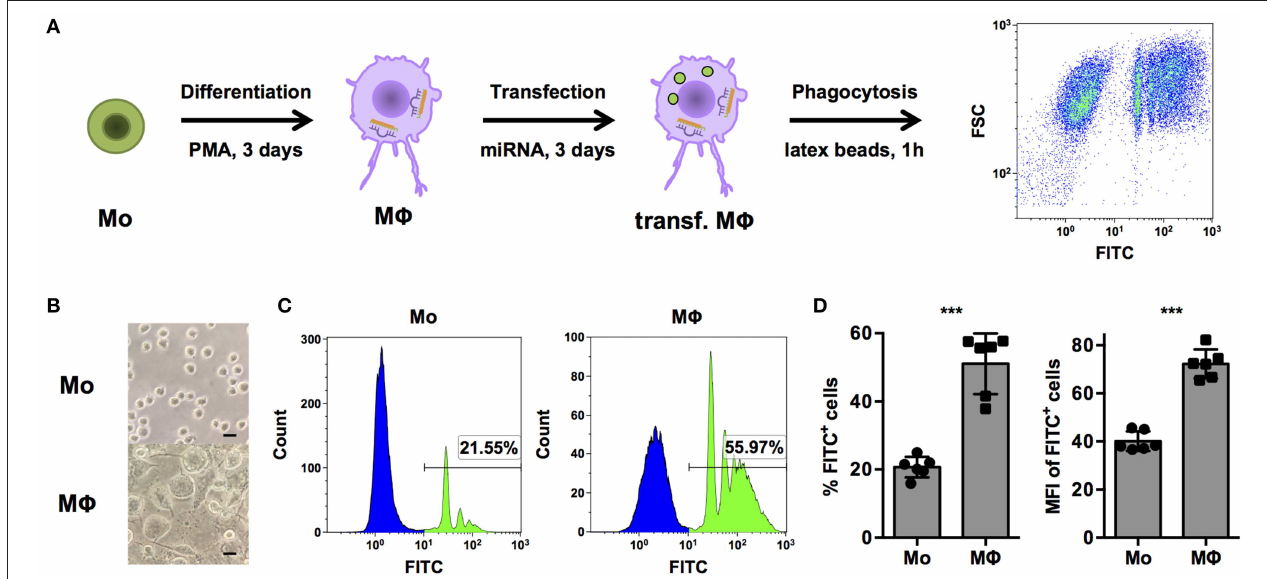
FIGURE 1 | PMA-activated THP-1 cells allow investigation of phagocytosis of opsonized latex beads by human M 8 . (A) Schematic representation of the workflow for differentiation, transfection, and analysis of phagocytosis of FITC-labeled, opsonized latex beads for high-content screening of a miRNA library and subsequent experiments. (B – D) Bright-field microscopy and FACS analysis of untreated (Mo) or PMA-activated (M 8 ) THP-1 cells. (B) Microscopic images were acquired with an AxioObserver Z1 microscope (Zeiss) using a 40 × objective. Scale bars represent 20 µ m. (C) Histogram plots of one representative experiment and (D) quantification of the percentage of FITC + (left) and mean fluorescence intensity (MFI) of FITC + cells (right) of n = 6 independent experiments. In (D) , values from each experiment are indicated by symbols and the mean ± standard deviation (SD) are indicated by a bar and whiskers. Statistical analysis was performed using Student’s t -test (*** p <